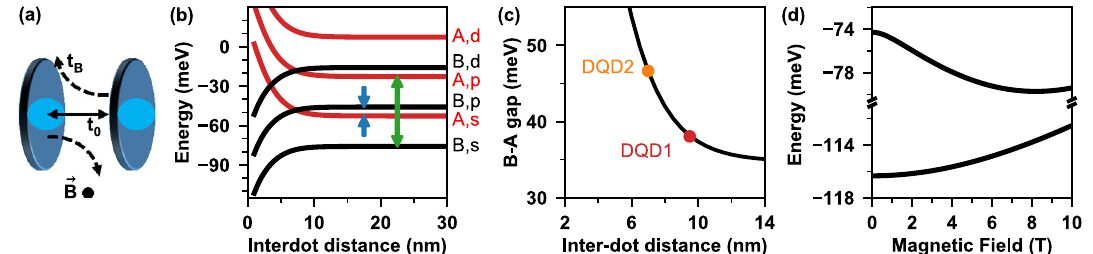
Figure 3. ( a ) Schematic representation of the tunnelling direction of electrons between dots for zero magnetic field, t 0 (solid line), and high field, t B (dashed lines), in the Voigt configuration. Light blue shading indicates the modified confinement region induced by the B-field. ( b ) Bonding (black) and antibonding (red) quantum molecular states of an electron. The blue arrows indicate the states whose coupling generates the emission line configuration in panel ( d ) and Fig. 2b. ( c ) The modelled energy gap between s-shell emission lines of the high- and low-energy dots as a function of inter-dot distance, L . The energy gaps from Fig. 1b are overlaid on the model curve, allowing us to verify the values of L for those samples. ( d ) Emission line model showing the same shift in tunnel coupling strength as observed in Fig. 1b, without Zeeman